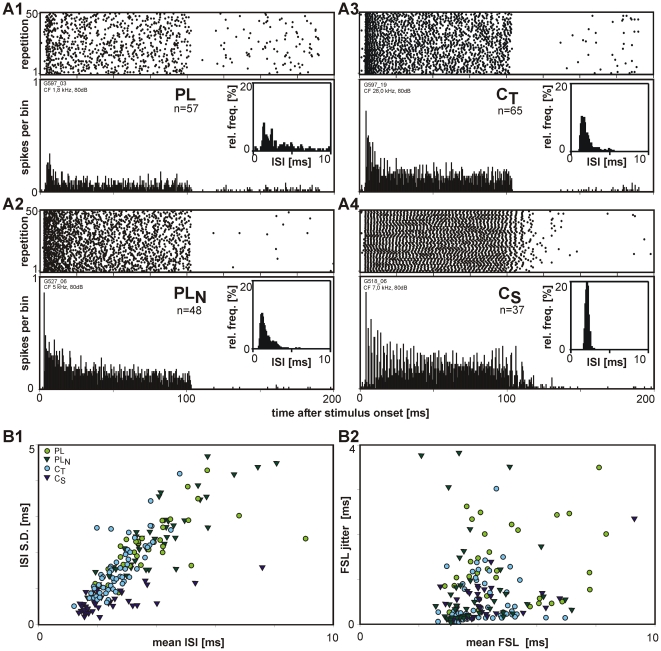
Classification of AVCN units based on PSTH types.
A1–A4: Response patterns during tone burst stimulation (100 ms, 80 dB SPL at CF) of four units; dot raster to 50 stimulus presentations above, PSTH below (bin width 0.5 ms). A1: primary-like (PL), A2: primary-like with notch (PLN), A3: transient chopper (CT), A4: sustained chopper (CS). The insets show the inter-spike interval (ISI) distribution during the first 20 ms of the stimulus of the respective units (bin width 0.1 ms); B1: Relation between mean ISI and S.D. of ISI for the different unit types (symbols as indicated in the figure) B2: Relation between the first spike latency (FSL) and the jitter of the FSL. Note that both types of chopper units have lower ISIs and a lower variation in ISI than PL and PLN units. Shortest latencies are observed in PLN units.